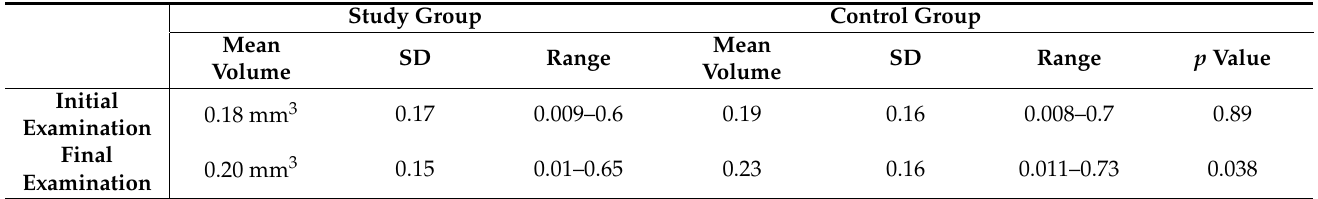
Table 2. Drusen volume growth as calculated by area and height, measured using optical coherence